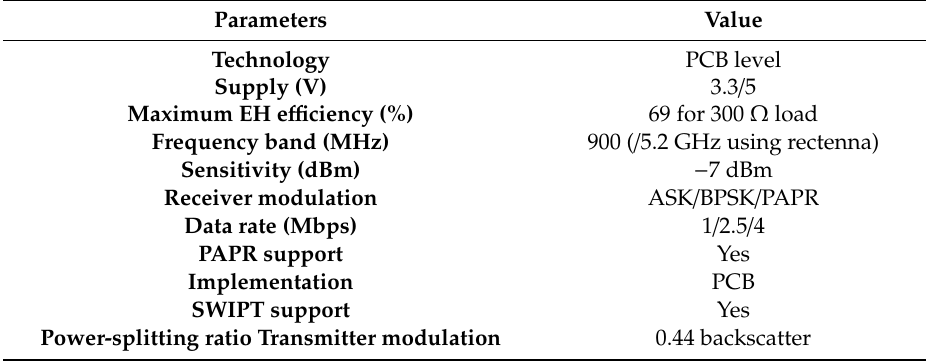
Table 1. Performance summary of the SWIPT